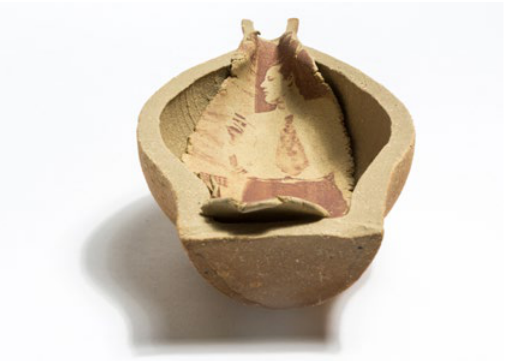
Figure 8.5 Impulse. Oxide print on stoneware clay inside hand-thrown dissected stoneware bottle (6 × 20